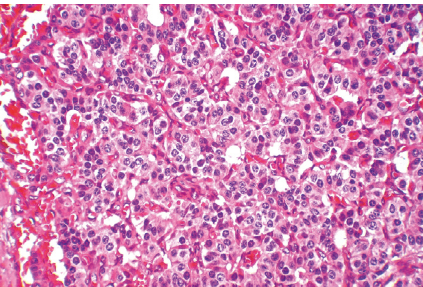
Figure4:Nuclearfeaturesshowcoarselyclumped,“saltandpepper” chromatin pattern.